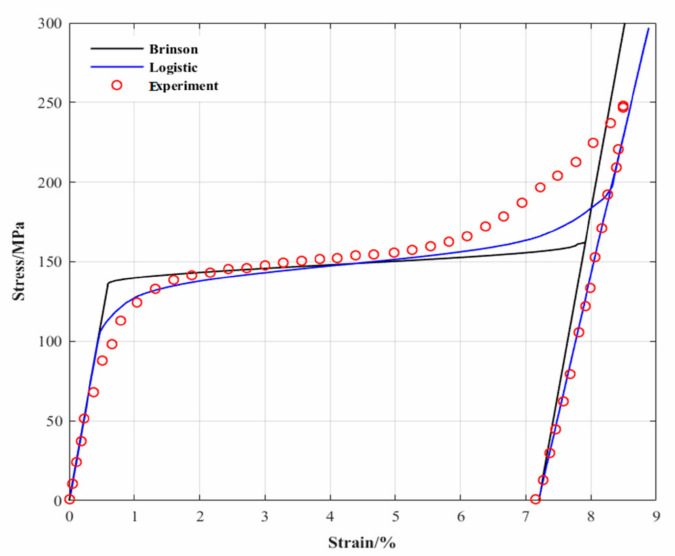
Figure 4. Comparison between the simulation and experimental results of the stress-strain relation- ship at − 10 ◦ C.